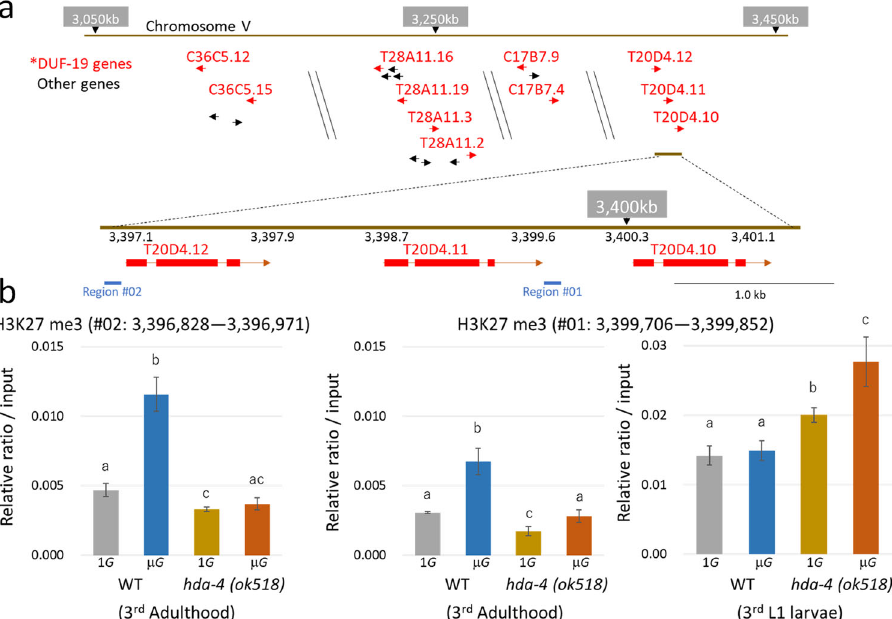
Fig. 4 ChIP analysis of H3K27me3 levels at the T40D4.12-4.10 locus. a H3K27me3 levels were analyzed in the intergenic region of the T40D4.12-4.10 locus on Chromosome V. The red-colored gene is a gene containing the DUF-19 domain. b The graphs show the recovery rates for region #01 and #02, as a relative ratio of DNA after ChIP with the anti-H3K27me3 monoclonal antibody compared to the input DNA in adults wild-type and hda-4 mutant, respectively. Due to the sample limitations, L1 larvae study was limited to analysis of the H3K27me3 status at the region #01. These samples (about 300 worms each) grew as third generation under arti fi cial 1 G or microgravity conditions. Biological triplications in each sample condition ( n = 3) were analyzed by ChIP-qPCR using one-way ANOVA followed by Tukey post hoc test. Error bars indicate